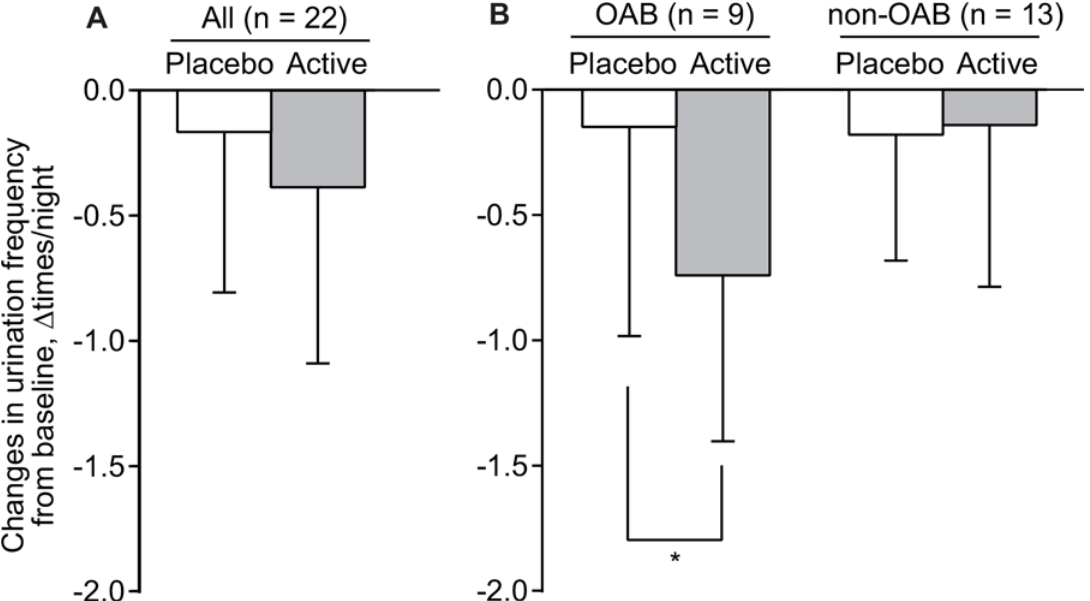
Fig 3. Changes in nighttime urination frequency during placebo and active stimulation periods from that during the baseline assessment period. Data are expressed as mean ± standard deviation. * p < 0.05; tested by paired t-test between active and placebo stimulation